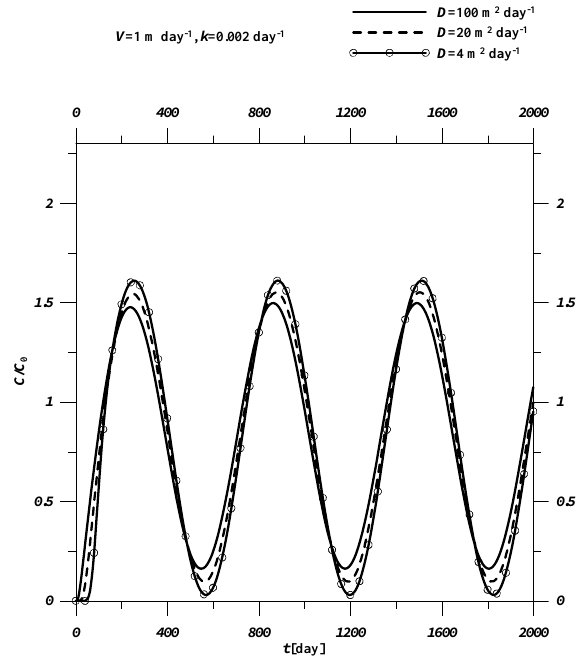
Fig. 2 Fig. 2. Comparison of the breakthrough curves at x = 100 m for different D . The sinusoidal periodic input function is f (t) = 1 + sin t . Parameter D is varied and other parameters are kept